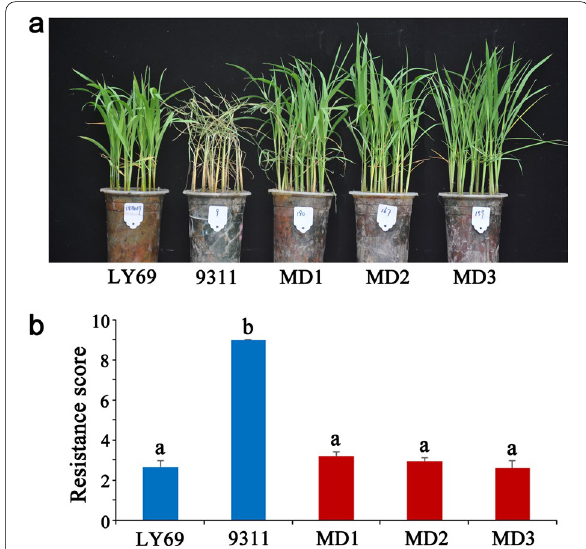
Fig. 6 Resistance of brown planthopper in the molecular design breeding lines. a : Morphology of rice seedlings fed by brown planthopper. b : Brown planthopper resistance score. 9311 used as susceptible control, LY69 used as resistant control. Values are the means s.d., n 30. Letters indicate a significant difference at the 5% ± = significance level by the least significant difference